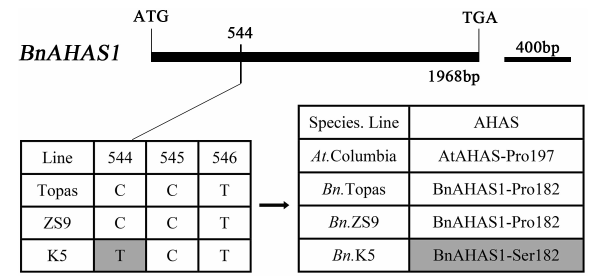
stamen of male sterile flowers were below the corolla and could barely be seen from outside due to remarkable elongation- inhibited filaments ( Figures 2B,E ). Moreover, unlike the pollens in the control plants ( Figure 2G and Table 2 ), almost no fertile pollens were observed in the ZS9 plants treated with 0.10 mg · L − 1 TBM ( Figure 2H and Table 2 ). There is no seed-setting upon bag-selfing ( Figure 2K ), but seed-setting recover normal upon open pollination (data not shown). Furthermore, the